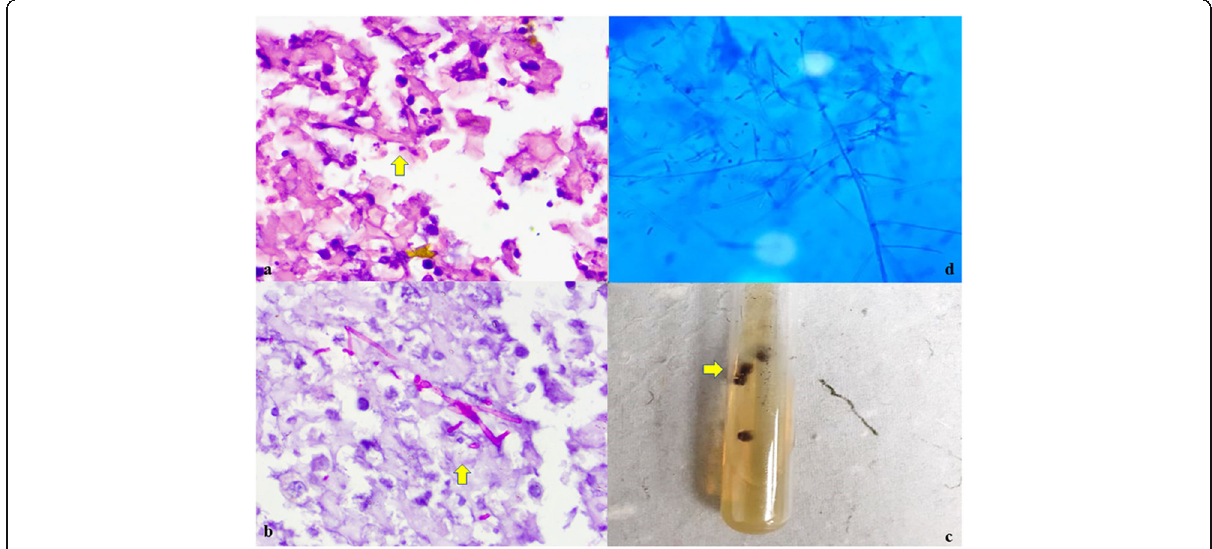
Fig. 4 a , b Microscopy showing numerous fungal hyphae with acute angle branching and inflammatory cells with PAS positivity. (H&E, × 100; PAS, × 100); c SDA slant showing surface greyish beige to black color and developed clusters of aerial hyphae; d Lactophenol cotton blue (LPCB) mount showing young hyphae forming thick bundles (fascicles), cylindrical phialides along the hyphae and oblong conidia. (LPCB, ×